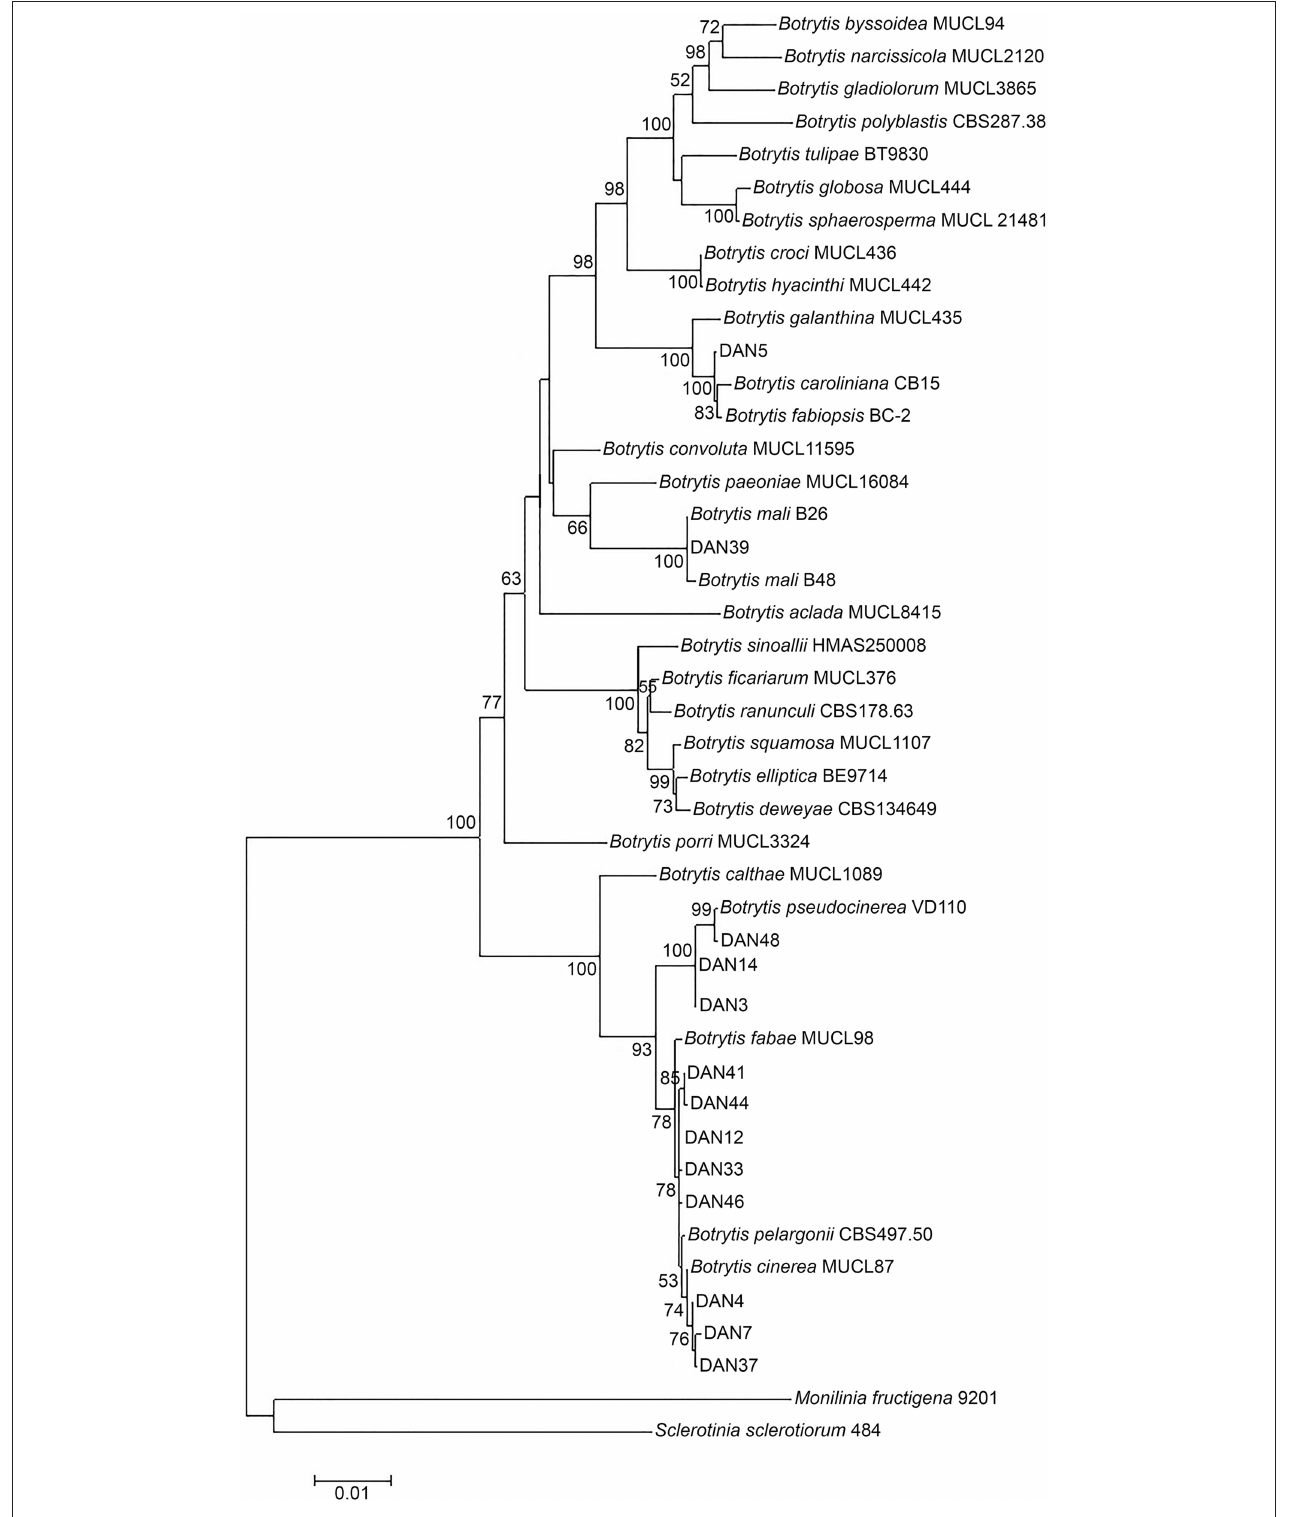
FIGURE 2 | Phylogenetic position of 13 Botrytis isolates from asymptomatic dandelion (labeled by DAN and a number) in the genus based on concatenated HSP60, G3PDH, and RPB2 sequences. Recognized Botrytis species are taken from Hyde et al. (2014). Phylogenetic tree construction used a maximum likelihood method with 1000 bootstraps. Only bootstrap values higher than 50% are displayed at the nodes.